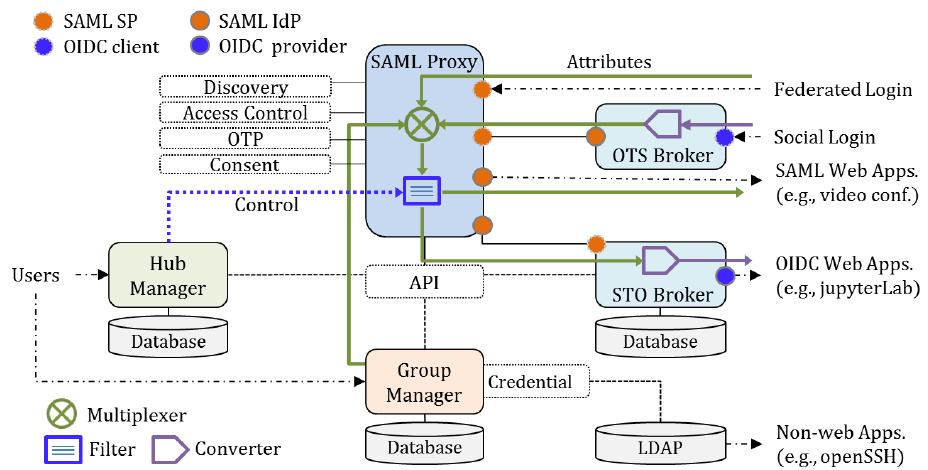
Figure 1. High-level overview of the developed federated-assess management